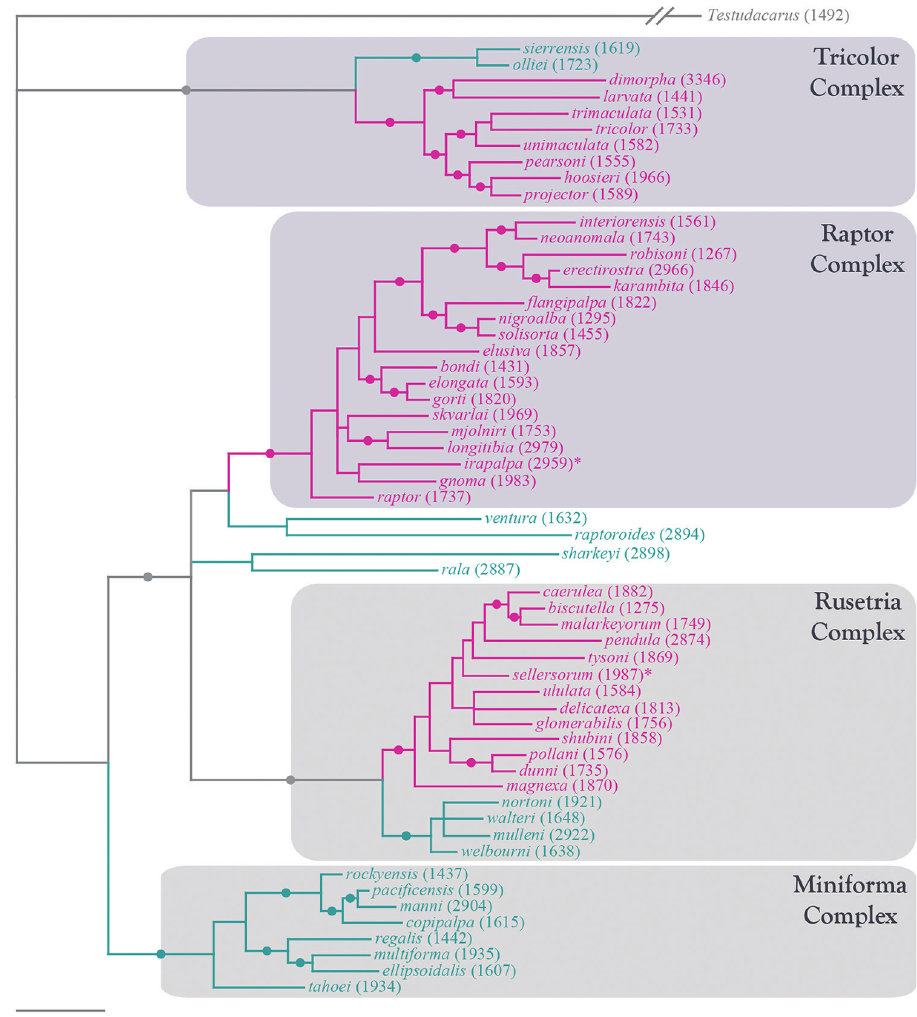
Figure 8. Bayesian inferred phylogram for combined analysis (28S+COI) of North American Torrenti- cola : distributions of 57 species. Pink represents lineages distributed in eastern North America and blue represents lineages distributed in western North America (gray branches represent lineages distributed in both regions). Species marked with an asterisk are primarily eastern but have distributions extending into the west. Note that larger lineages contain species distributed in either the east or west, but not both. Numbers are DNA identification numbers. Scale bar indicates 0.1 substitutions per site. Dots denote posterior probably